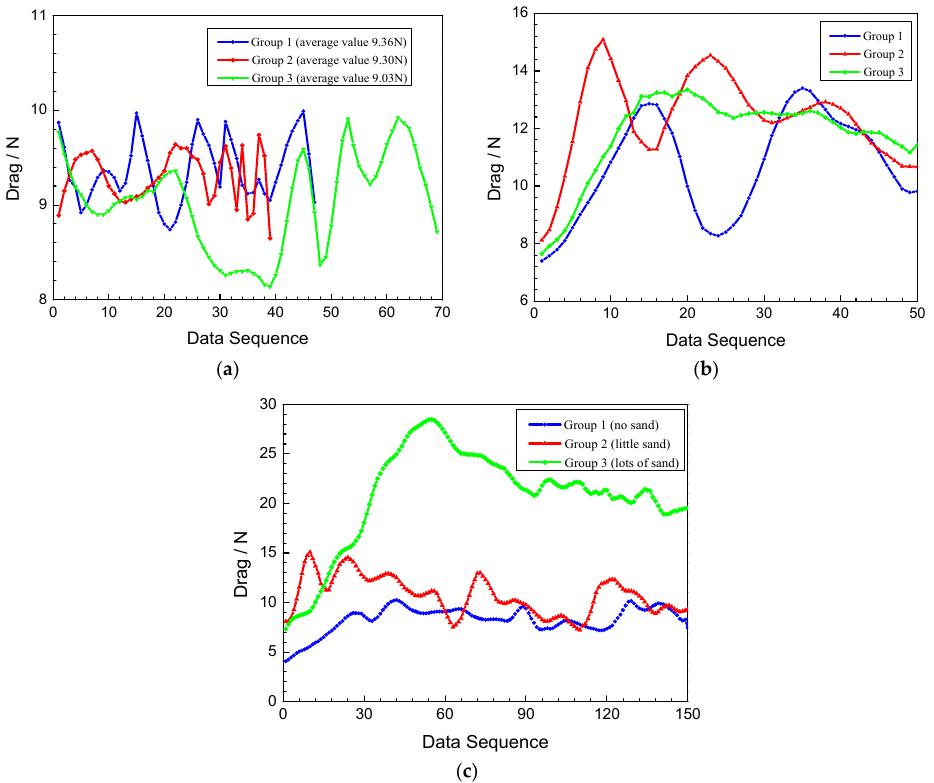
Figure 13. Local typical drag curves of the cement column in the hard plastic cylinder: ( a ) The hard plastic cylinder has no sand particles; ( b ) the hard plastic cylinder has little sand particles; and ( c ) the hard plastic cylinder has lots of sand particles.